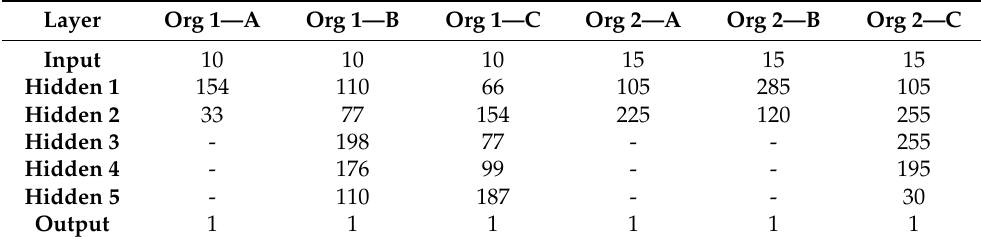
Table 5. Number of layers and neurons per model and validation